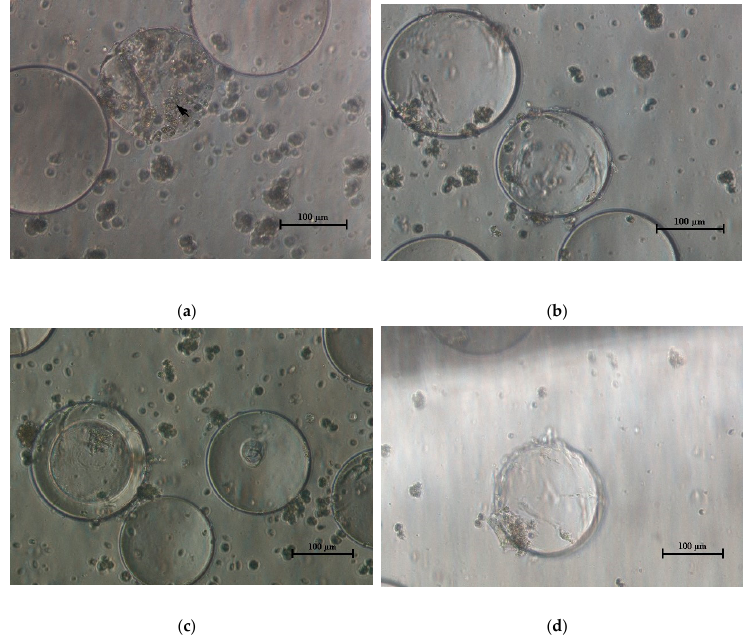
Figure 2. Inverted microscopic image of Cytodex™ 1 microcarrier beads with attached CEL cells infected with FAdV showing detachment of cells from the microcarrier beads. ( a ) Infected with UPM08136CELP5 at 24 h post-inoculation (pi). ( b ) Infected with UPM08136CELP5 48 h pi. ( c ) Infected with UPM08136CELP20 at 24 h pi. ( d ) Infected with UPM08136CELP20 at 48 h pi. 3.3. Infective Dose (TCID 50 ) of UPM08136P5B1 and UPM08136P20B1 Isolates The UPM08136CELP5B1 showed higher virus titer of 1 × 10 7.5 TCID 50 / mL in a final volume of 500 mL when compared to UPM08136CELP20B1 with virus titer of 1 × 10 6.5 TCID 50 / mL in a final volume of 600 mL. These could be due to final culture volume or infectivity of the isolate (Table 4). Table 4. Final volume and virus titer (TCID 50 ) of FAdV propagated in CEL cells adapted on Cytodex™